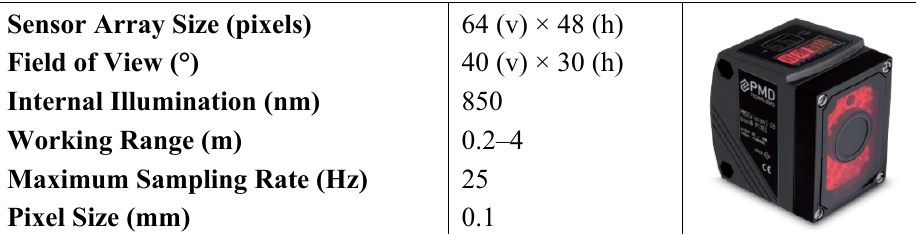
Table 1. PMD[vision]-O3 camera specifications.